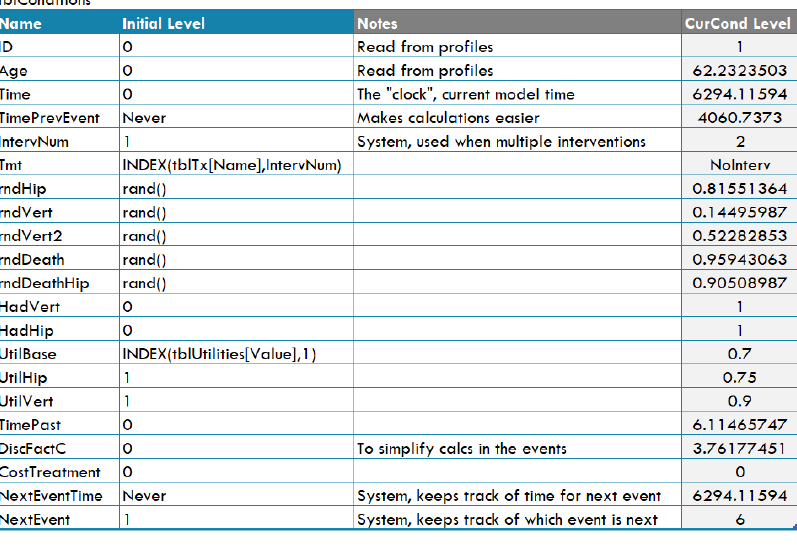
Figure A11. Table of conditions for the osteoporosis model in